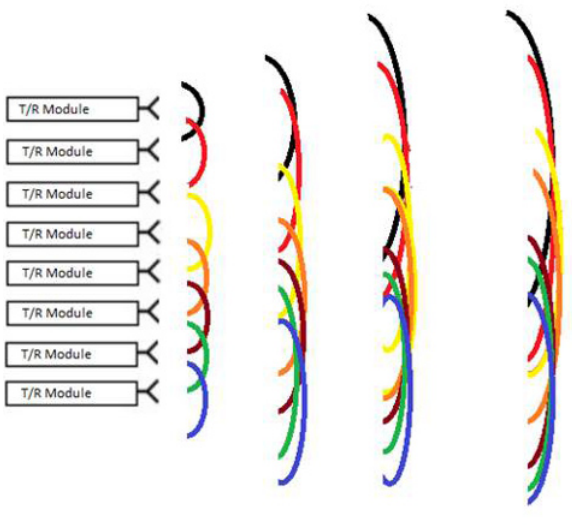
Table 1. Radar Performance Requirements